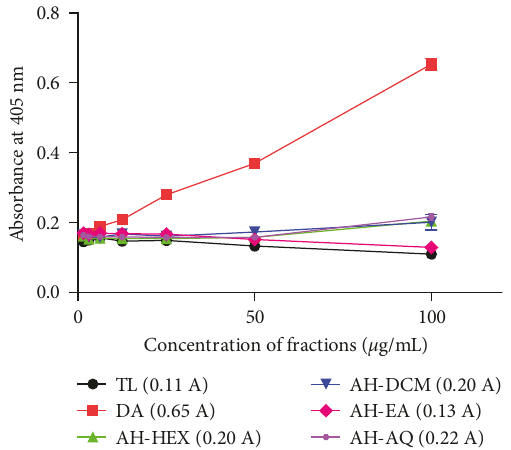
Figure 4: Antioxidant activities of fractions in T. b brucei . Ab- sorbance was read within a concentration range of 1.5625 and 100 μ g/mL. Hexane fraction � AH-HEX, dichloromethane frac- tion � AH-DCM, ethyl-acetate fraction � AH-EA, aqueous frac- tion � AH-AQ, DA � Diminazene aceturate, TL � Trolox, A � absorbance units at 100 μ